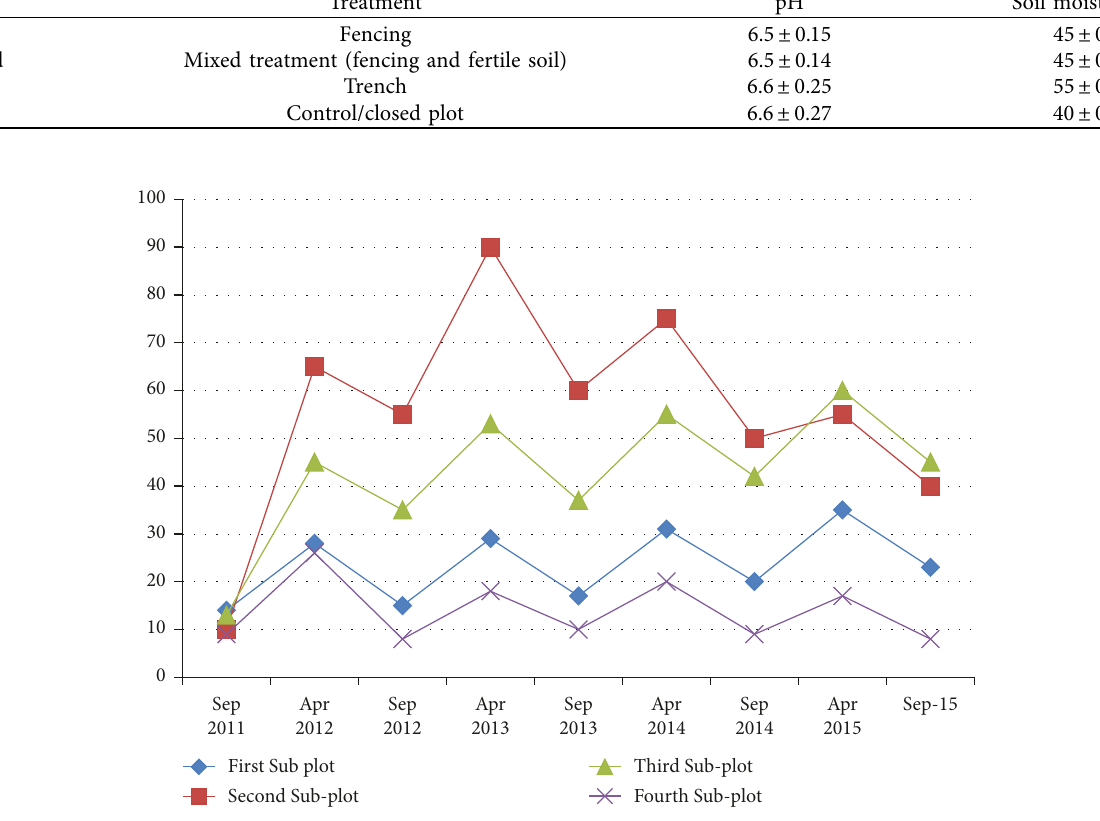
Figure 1: Number of plants in the first, second, third, and fourth plots treated through different treatments ( source: field data 2011 to 2015